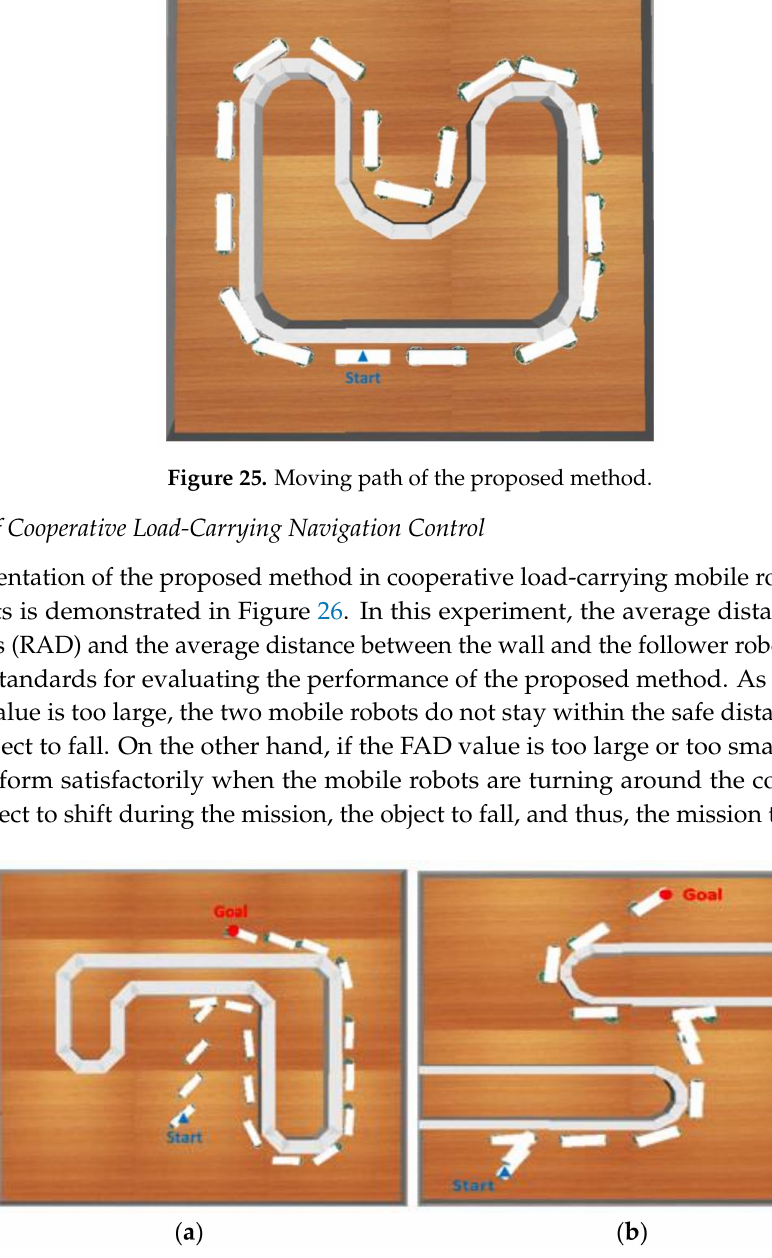
Figure 26. Moving path of cooperative load-carrying navigation control in ( a ) testing environment 1 and ( b ) testing environment 2. Table 5. Performance of cooperative load-carrying navigation